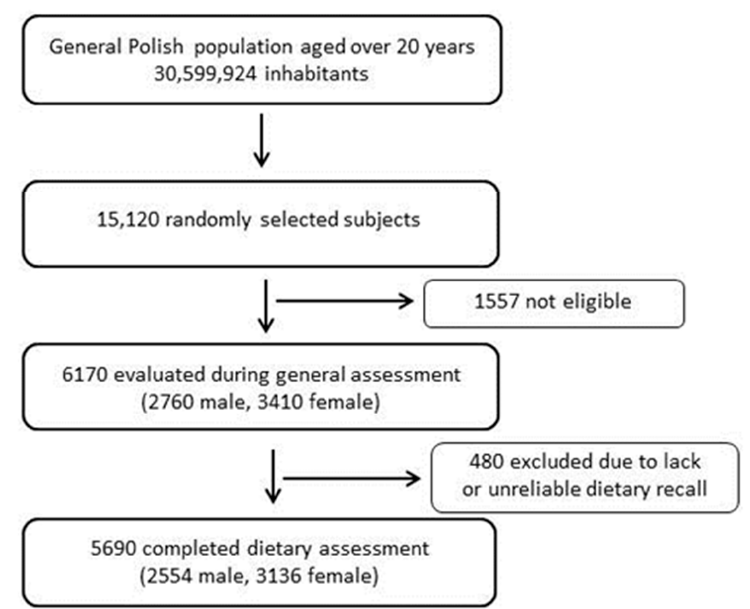
Figure 2. Flow chart of the study participants. Data on the demographic status, diseases, leisure-time physical activity, tobacco use, community size, marital status, and education level of the participants were collected using a standardized questionnaire developed for the WOBASZ II survey. Height and weight measurements were taken by personnel trained in standard procedures. Body mass index (BMI) was calculated from body weight in kilograms divided by the square of the height in meters. Blood pressure (BP) was measured three times on the right arm after 5 min of rest in a sitting position at 1 min intervals, and final BP was reported as the mean of the second and third measurements. The general characteristics of the study group are shown in Table